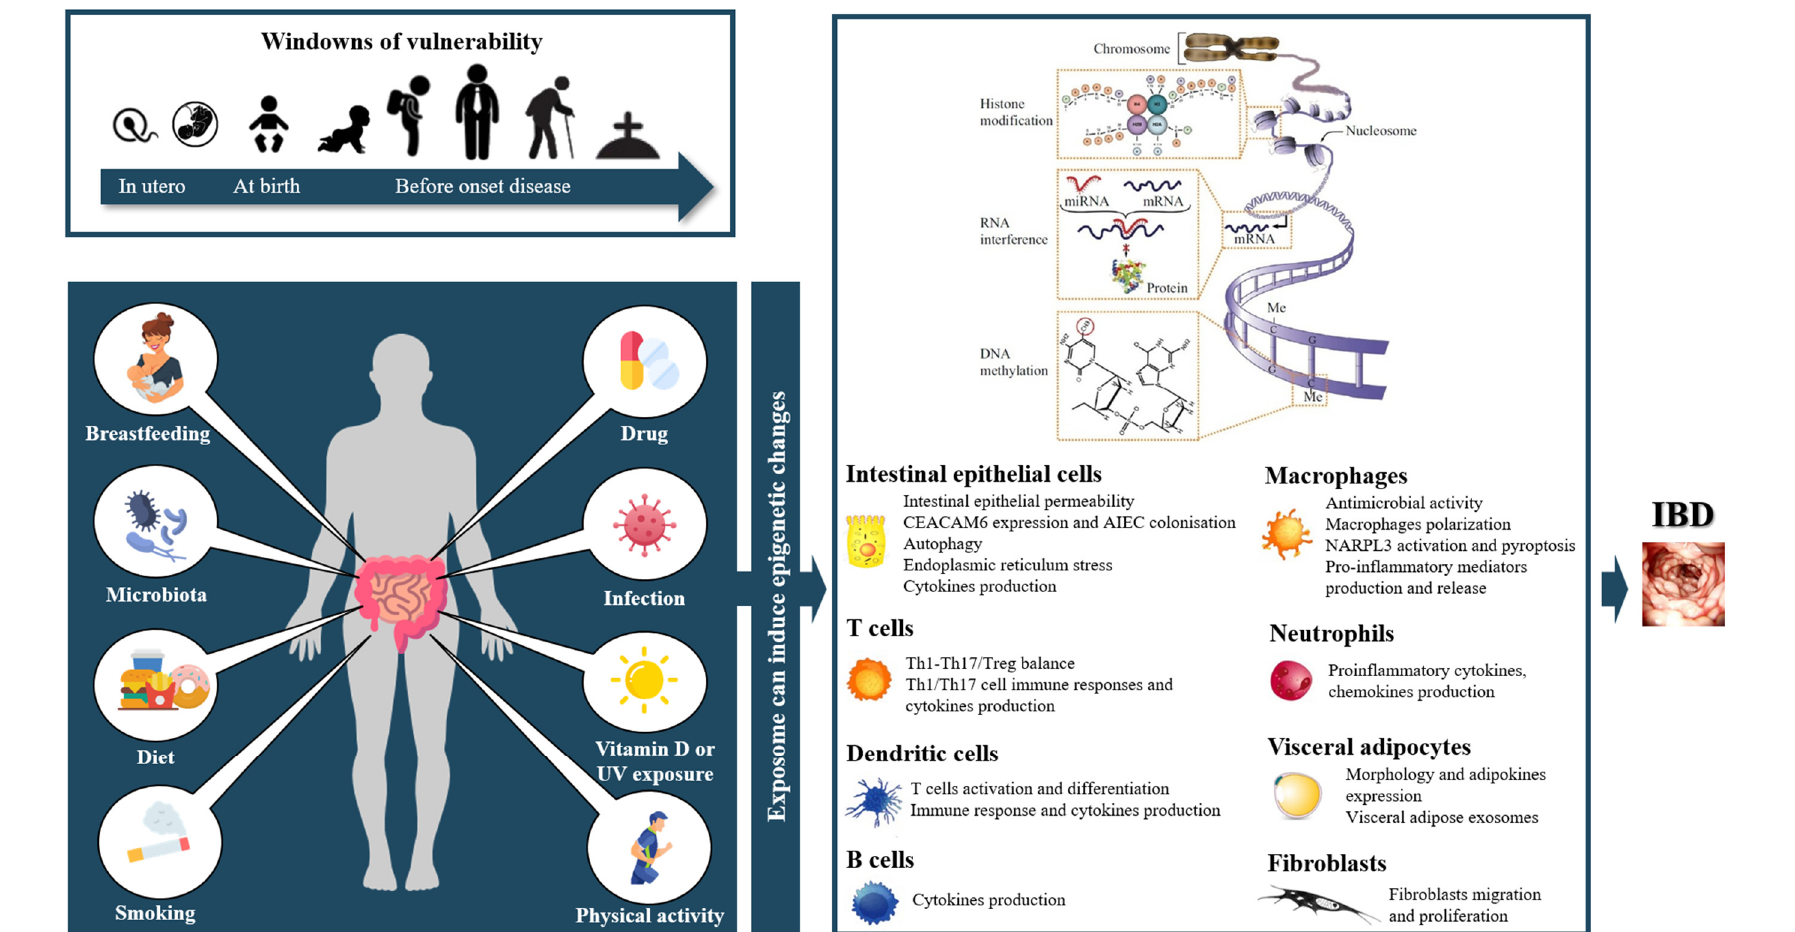
Figure 1. Summary (adapted from Sawan et al. [323]). The environmental factors epigenetically influencing the occurrence of intestinal inflammation are breastfeeding, microbiota, diet, smoking habits, drugs, infections, vitamin D and physical activity. Although present at all times, it is mainly during the prenatal period, at birth and just before the onset of the disease that these factors play a key role in triggering the disease. These environmental factors, by inducing DNA methylation, histone modifications and ncRNAs in different cell types, trigger the pathways involved in IBD pathophysiology and contribute to disease initiation.